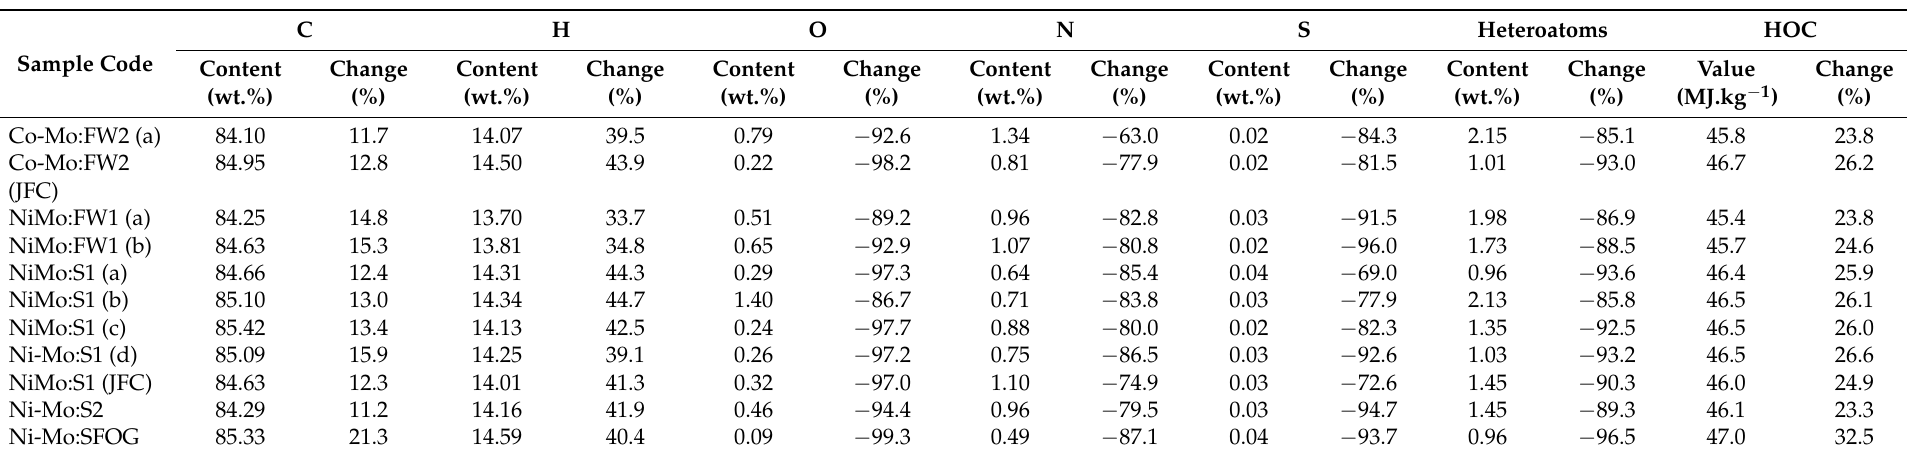
Table 4. Elemental composition of the upgraded wet-waste HTL biocrudes obtained, and the changes observed relative to the starting material.